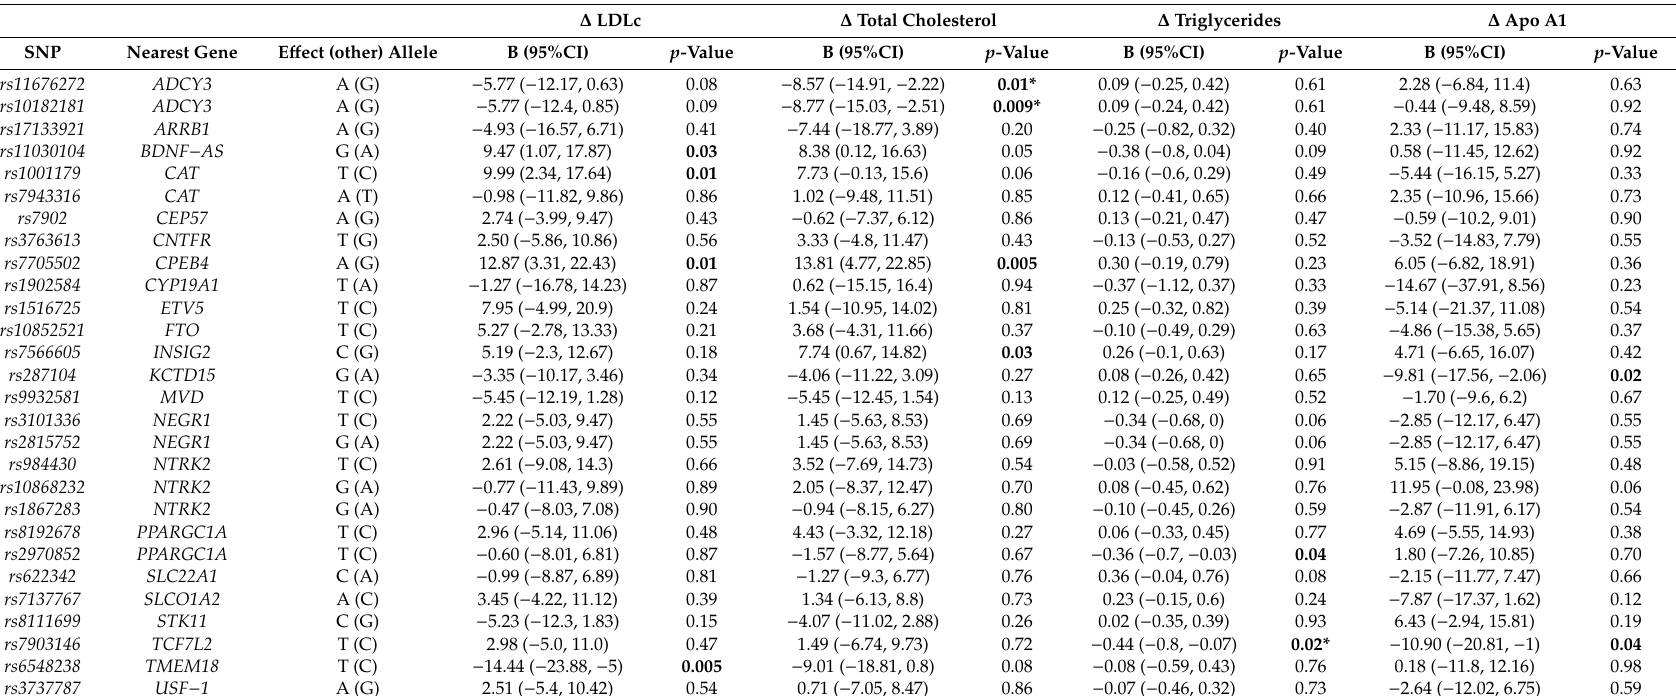
Table 3. Summary of association data for the 28 selected common variants in lipid metabolism